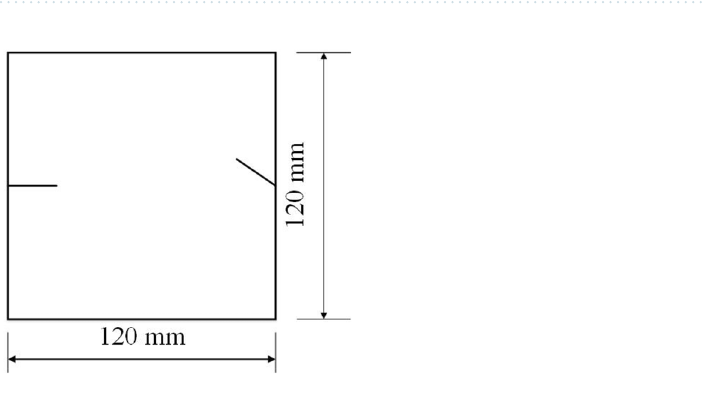
Figure 48. Both cracks 20 mm long, in specimens with different particle